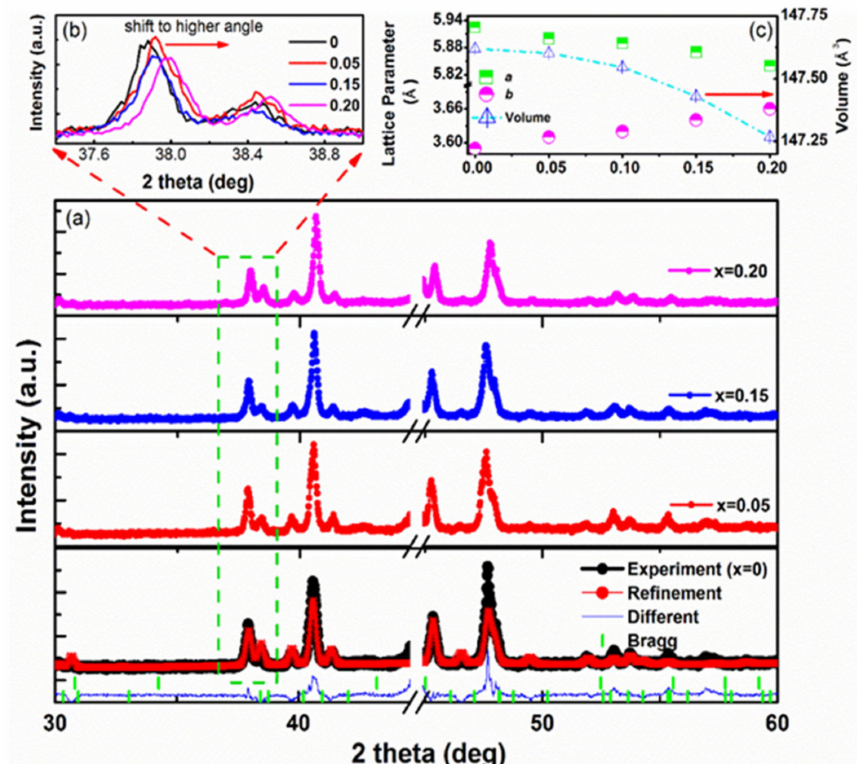
Figure 1. ( a ) Refined XRD pattern of MnCoGe 1 − x Si x (x = 0.05, 0.10, 0.15, and 0.20) measured at room temperature. ( b ) The inset shows the patterns for the indicated range of the MnCoGe 1 − x Si x samples, representing that the Bragg peaks shifted to the higher angles. ( c ) Rietveld refinement analysis indicating the unit cell volumes and lattice